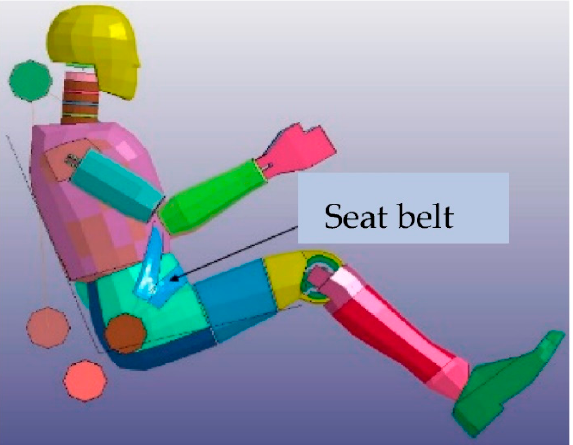
Figure 8. The virtual model of the dummy conditioned for the collision.